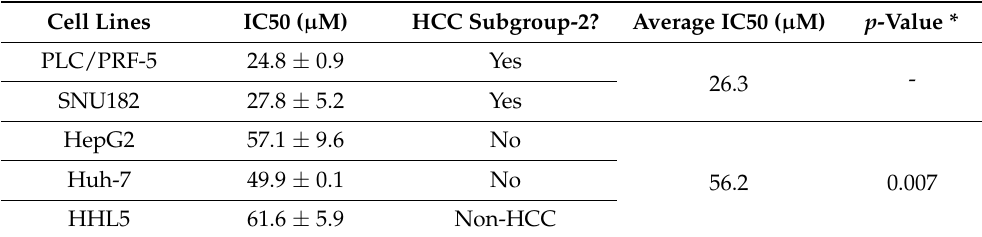
Table 1. The cytotoxicity of NSC23766 on HCC and non-HCC-subgroup determined by MTT assay. Cell Lines IC50 ( µ